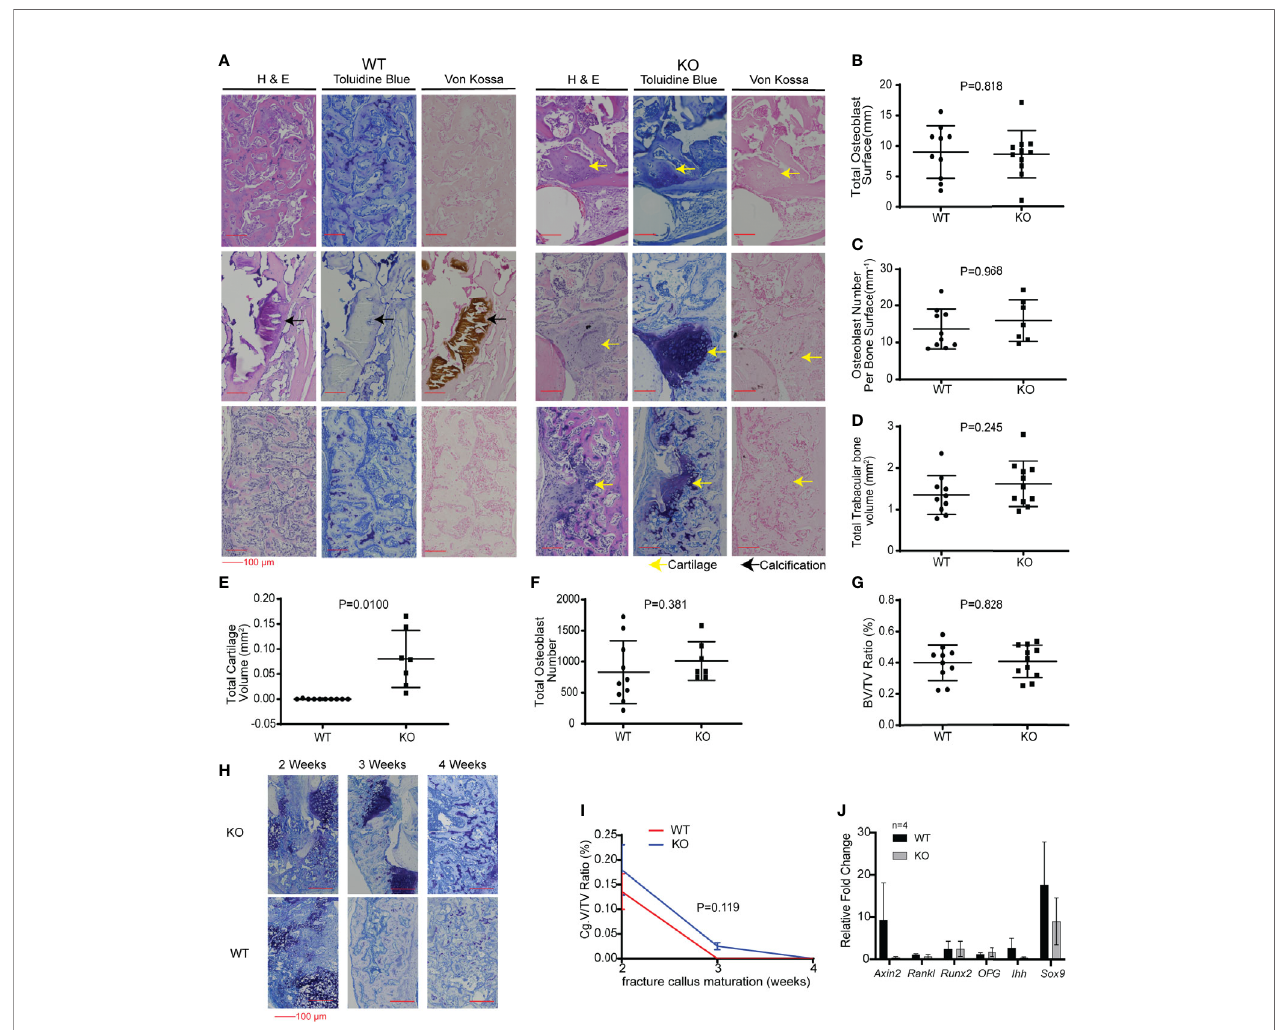
FIGURE 6 | Hematopoietic Wnt-depleted mice had delayed callus maturation with more cartilage. (A) Histology of representative mice callus samples 3 weeks after injury from each group, demonstrated increased cartilage in the callus in the KO compared to the WT mice. (B – H) Quantitative evaluation of the fracture callus 3 weeks after injury were done by determining the (B) Total osteoblast surface (mm), (C) osteoblast number per bone surface (mm3), (D) total trabecular bone volume (mm3), (E) total cartilage volume (mm2), (F) total osteoblast number and (G) bone volume to total callus volume ratio (%). Total cartilage volume (E) was signi fi cantly less in the KO compared to the WT callus samples. (H) Representative images showing progressive maturation of the fracture callus in hematopoietic Wnt-depleted mice (KO) and wild type mice (WT). (I) Cartilage volume to total volume ratio (%) during the 1st 4 weeks after injury, demonstrating that the fracture calluses from the KO mice matured to woven bone after 4 weeks. (J) Quantitative polymerase chain reaction (qPCR) evaluation of the fracture callus at 3 weeks for relative expression of Wnt target gene ( Axin2 ), bone turnover ( RankL ), osteoblastic genes ( Runx2, Opg ) and chondrogenic genes ( Ihh, Sox9 ) revealed no signi fi cant difference in the 2 groups of mice. N=4 mice per